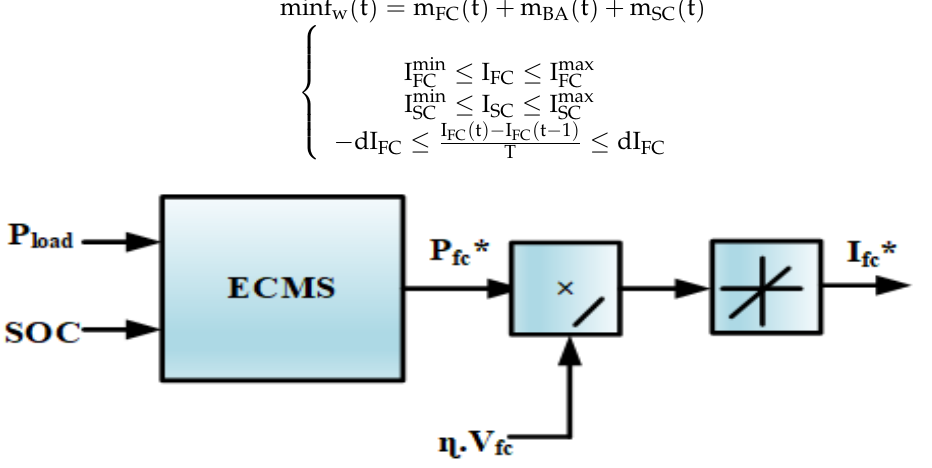
Figure 7. Equivalent consumption minimization method.